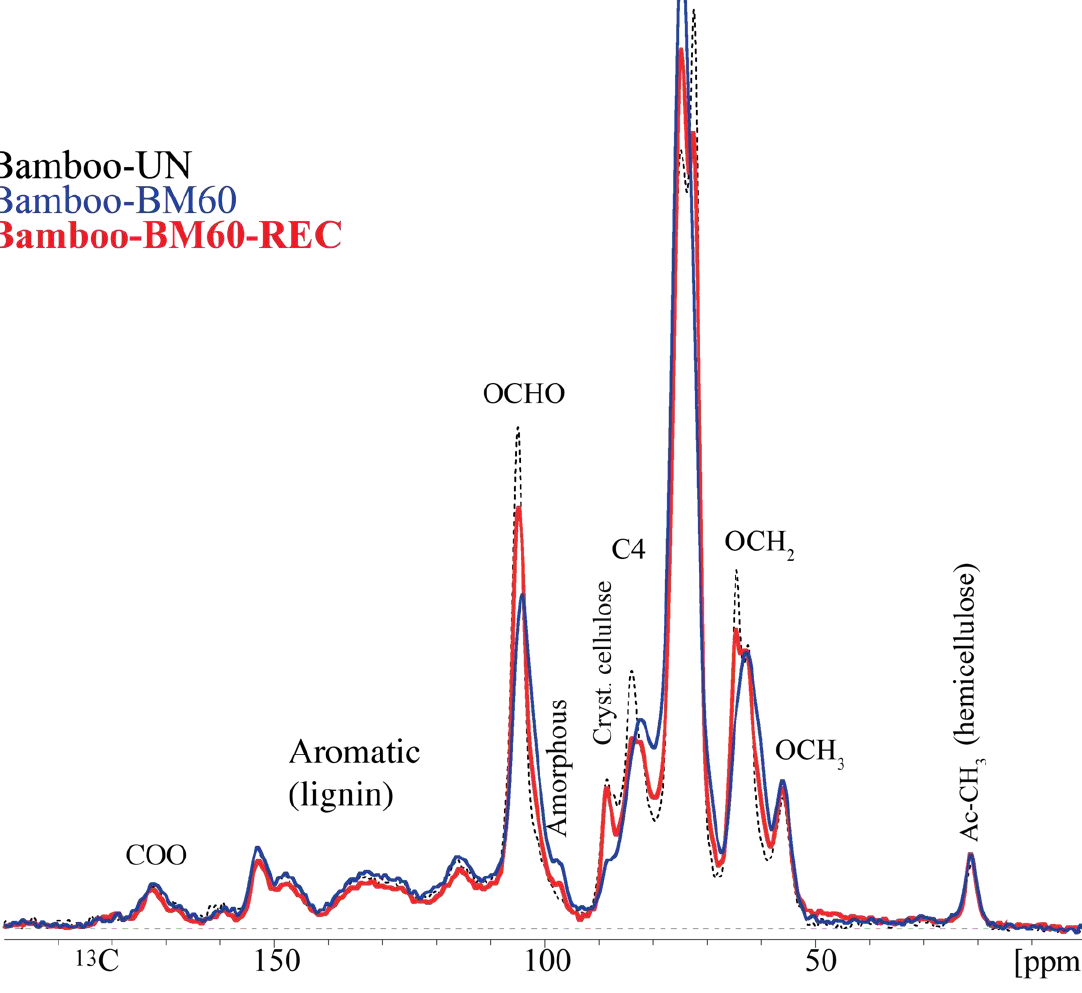
Figure 1. MultiCP 13 C NMR spectra of bamboo-UN, bamboo-BM60, and bamboo-BM60-REC. Table 1 provides descriptions of these samples.